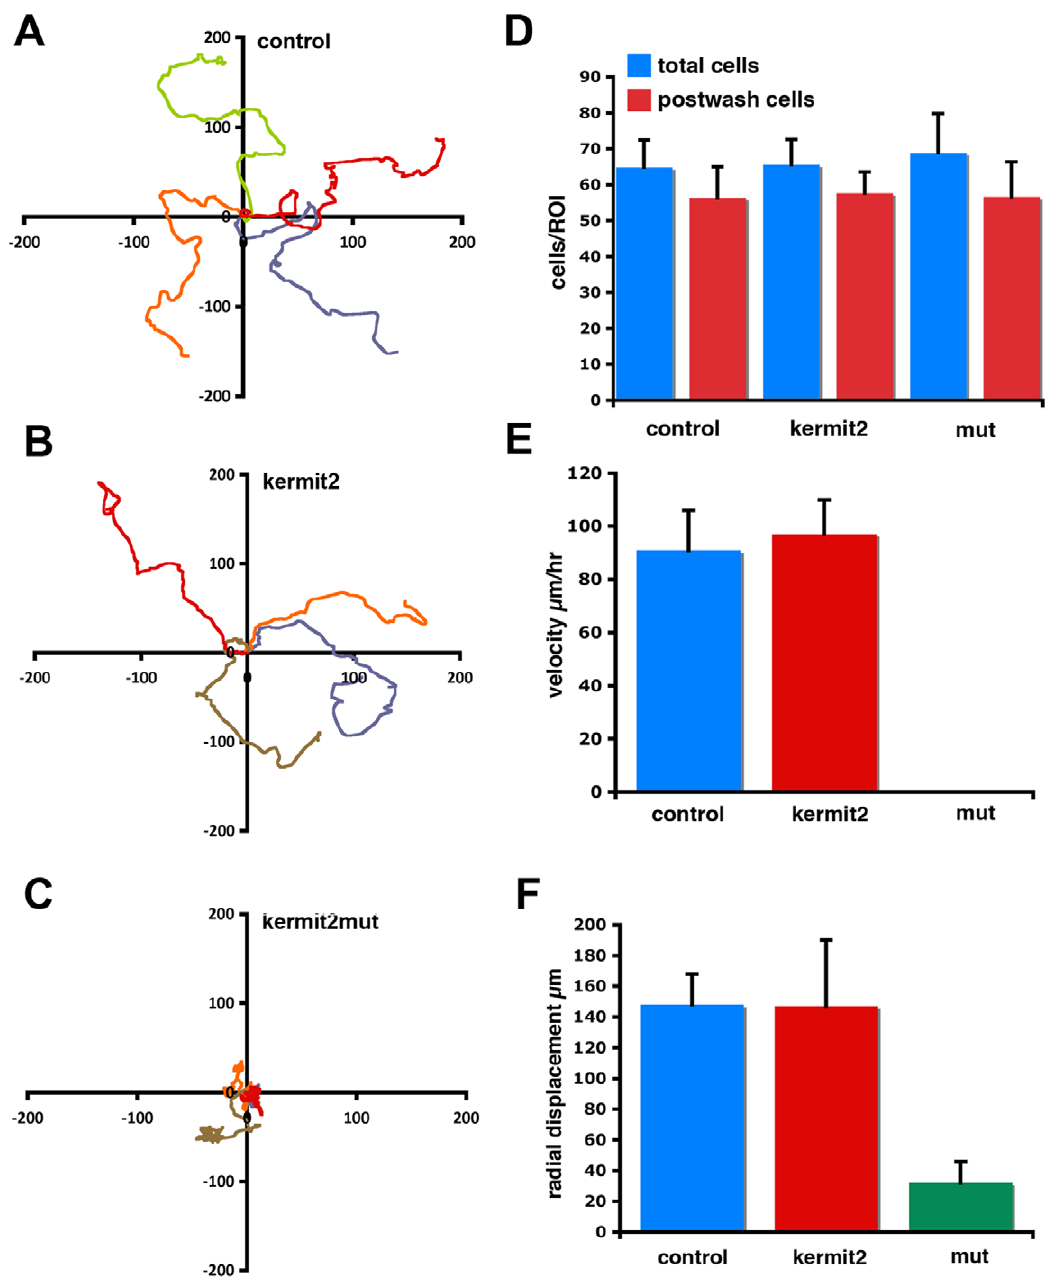
Figure 7. Cell adhesion assays. (A–C) Spider graphs representing migration tracks of individual cells plated on FN substrates. Each graph contains 4 representative tracks with the start point set to (0,0). Horizontal and vertical scale is in m M. (C) Kermit2 mut expressing cells have reduced migration paths as compared to (A) control and (B) kermit2 expressing cells. (D) Quantification of activin-treated cell adhesion to FN substrates. Cells were plated on FN substrates and counted pre-wash (blue) and after washing to remove non-adherent cells (red). Control, kermit2, and kermit2 mut expressing cells all show similar affinity for FN substrates. (E) Activin-treated cell migration rate mediated by kermit2. Average cell migration velocities were measured using the track cells function of Openlab. The value for each construct represents the average ( 6 SD) of 45 cells from three spawnings. Cells expressing the kermit2 mut construct (0.6 m M/hr) migrate significantly (P , 0.005) slower than control (91 m M/hr) or kermit2 (97 m M/hr) expressing cells. (F) The radial displacement of activin-treated cells on FN substrates. Measurements are from the same cells as represented in (E). Kermit2 mut expressing cells travel significantly (P , 0.01) less distance (32 m M) than control (148 m M) or kermit2 expressing cells (147 m M).